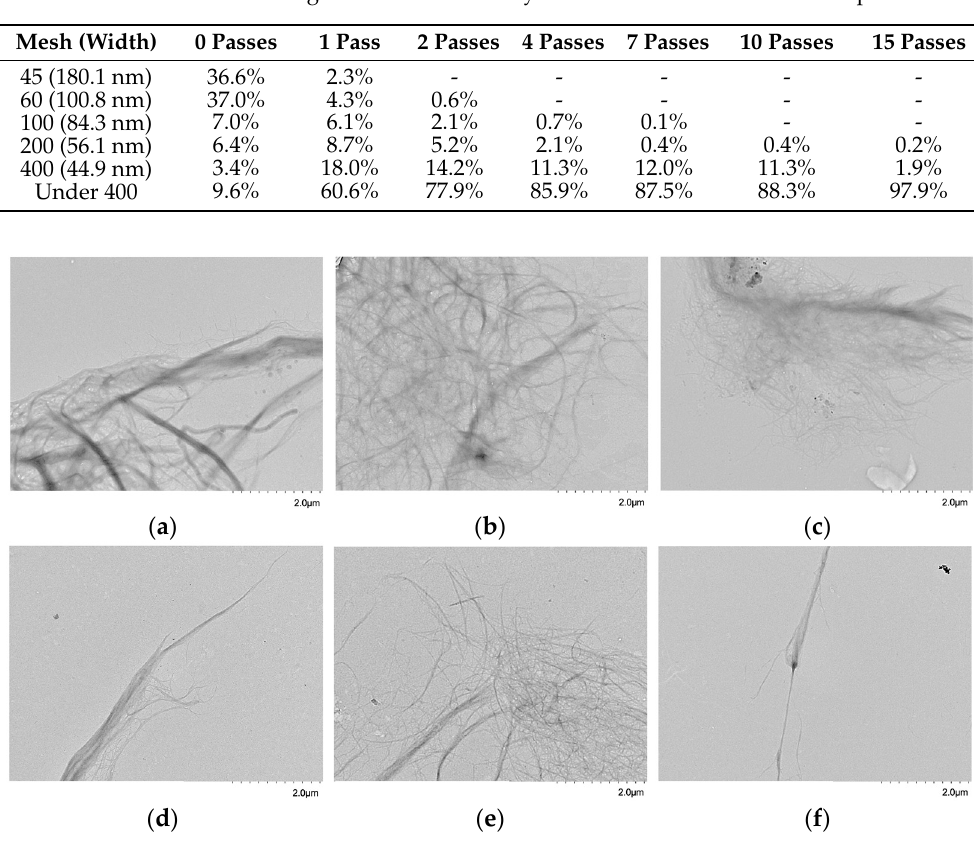
Figure 1. TEM micrographs of CNFs fractioned by size: ( a ) 45 mesh, ( b ) 60 mesh, ( c ) 100 mesh, ( d ) 200 mesh, ( e ) 400 mesh, and ( f ) under 400 mesh (scale: 2 μ m, magnification: ×5.0 k).